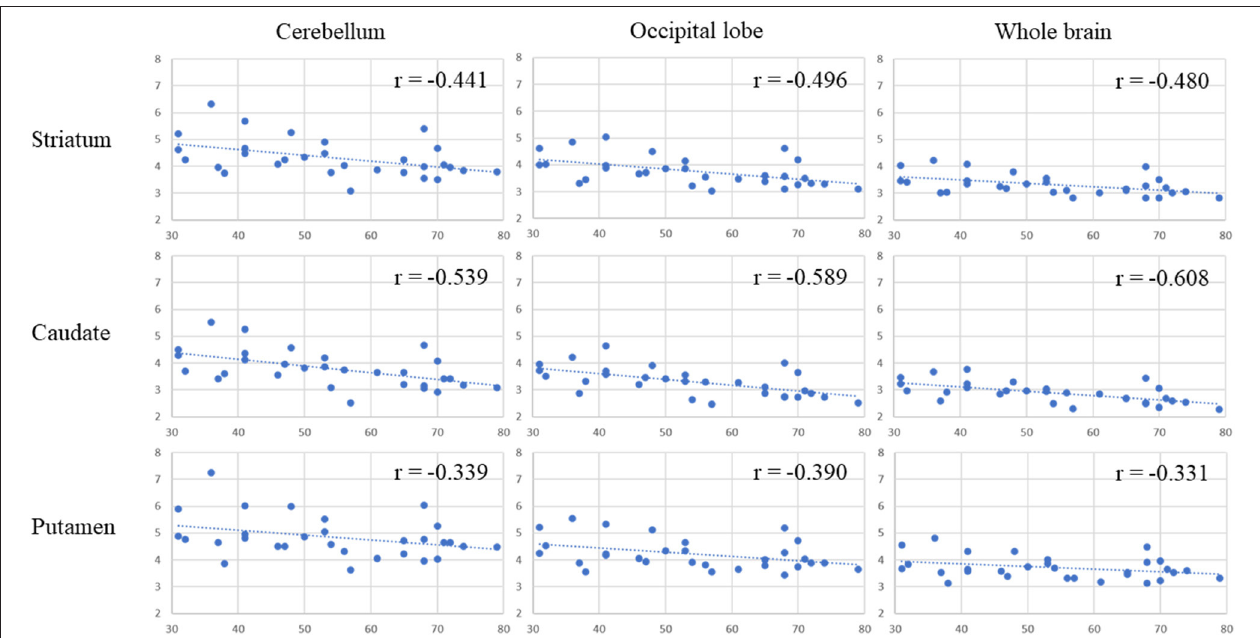
FIGURE 3 | Age correlation with DAT activity, measured with DAT-SPECT and DAT-PET in the multi-atlas MRI-based method. In each correlation figure, the vertical axis indicates the semi-quantitative uptake for DAT-SPECT measured by the multi-atlas MRI-based method, and the horizontal axis indicates age. There are 3 × 3 correlation figure patterns in two different cases: where the target region is the striatum, caudate, or putamen and where the reference area is the cerebellum, occipital lobe or whole brain.